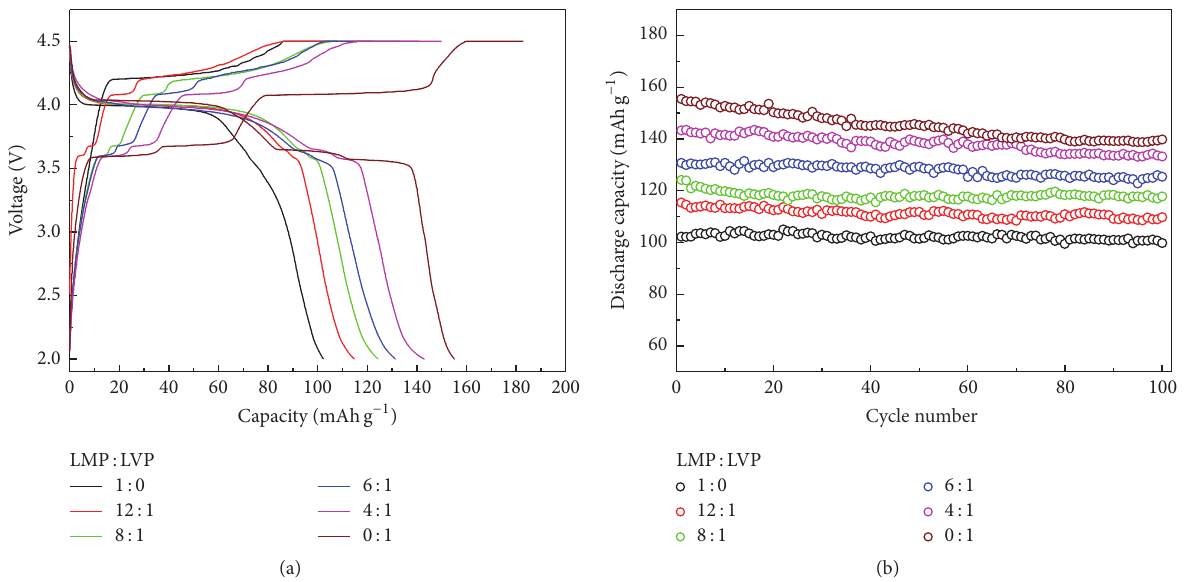
2.43.24.02.43.24.0